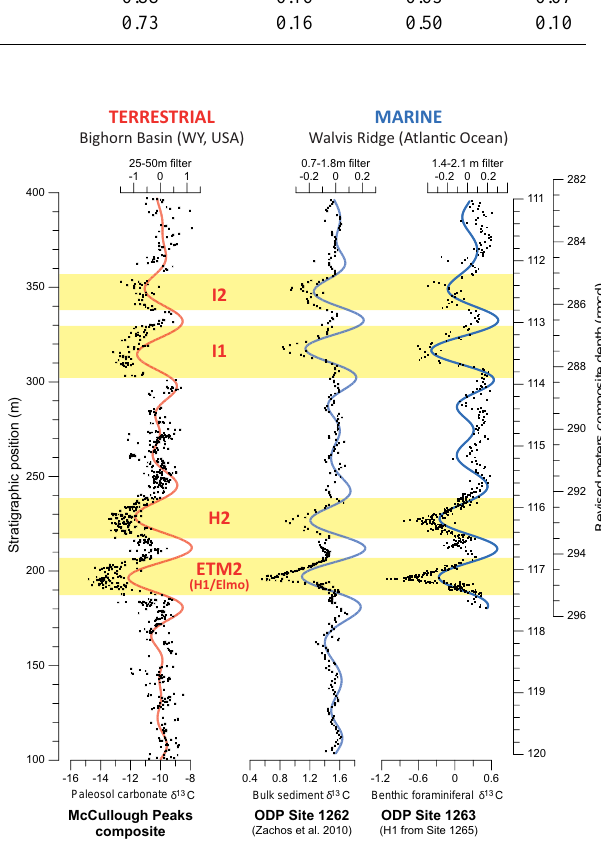
Figure 3. The McCullough Peaks paleosol carbonate carbon iso- tope stratigraphy compared in-depth domain to the bulk sediment and benthic foraminiferal ( Nuttallides truempyi ) carbon isotope stratigraphies at, respectively, ODP Site 1262 (left y axis on right side; Zachos et al., 2010) and 1263 (right y axis on right side; Stap et al., 2010a; this study) at Walvis Ridge in the southern Atlantic Ocean. Filters denote the ∼ 100kyr eccentricity band in the three records. Note that linear stretching of depth scales is sufficient to construct the figure, indicating the constant average sedimentation rates on longer timescales in both realms. On smaller timescales, large sedimentation rate differences occur that in the marine realm relate to carbonate dissolution during and carbonate overshoot after the hyperthermal